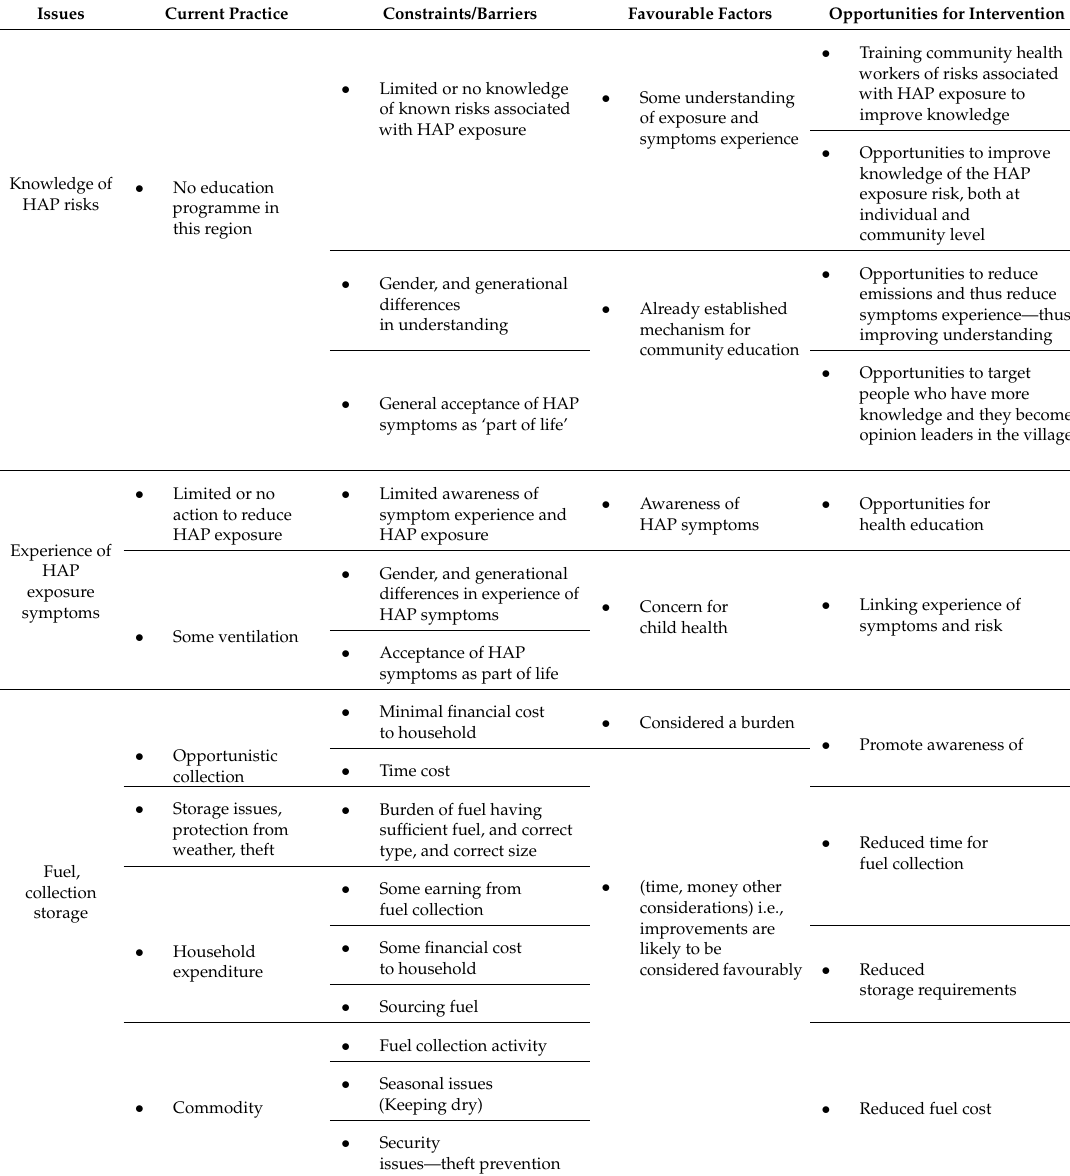
Table 2. Summary of all results, including issues, current practice, constraints/barriers, favourable factors and opportunities for